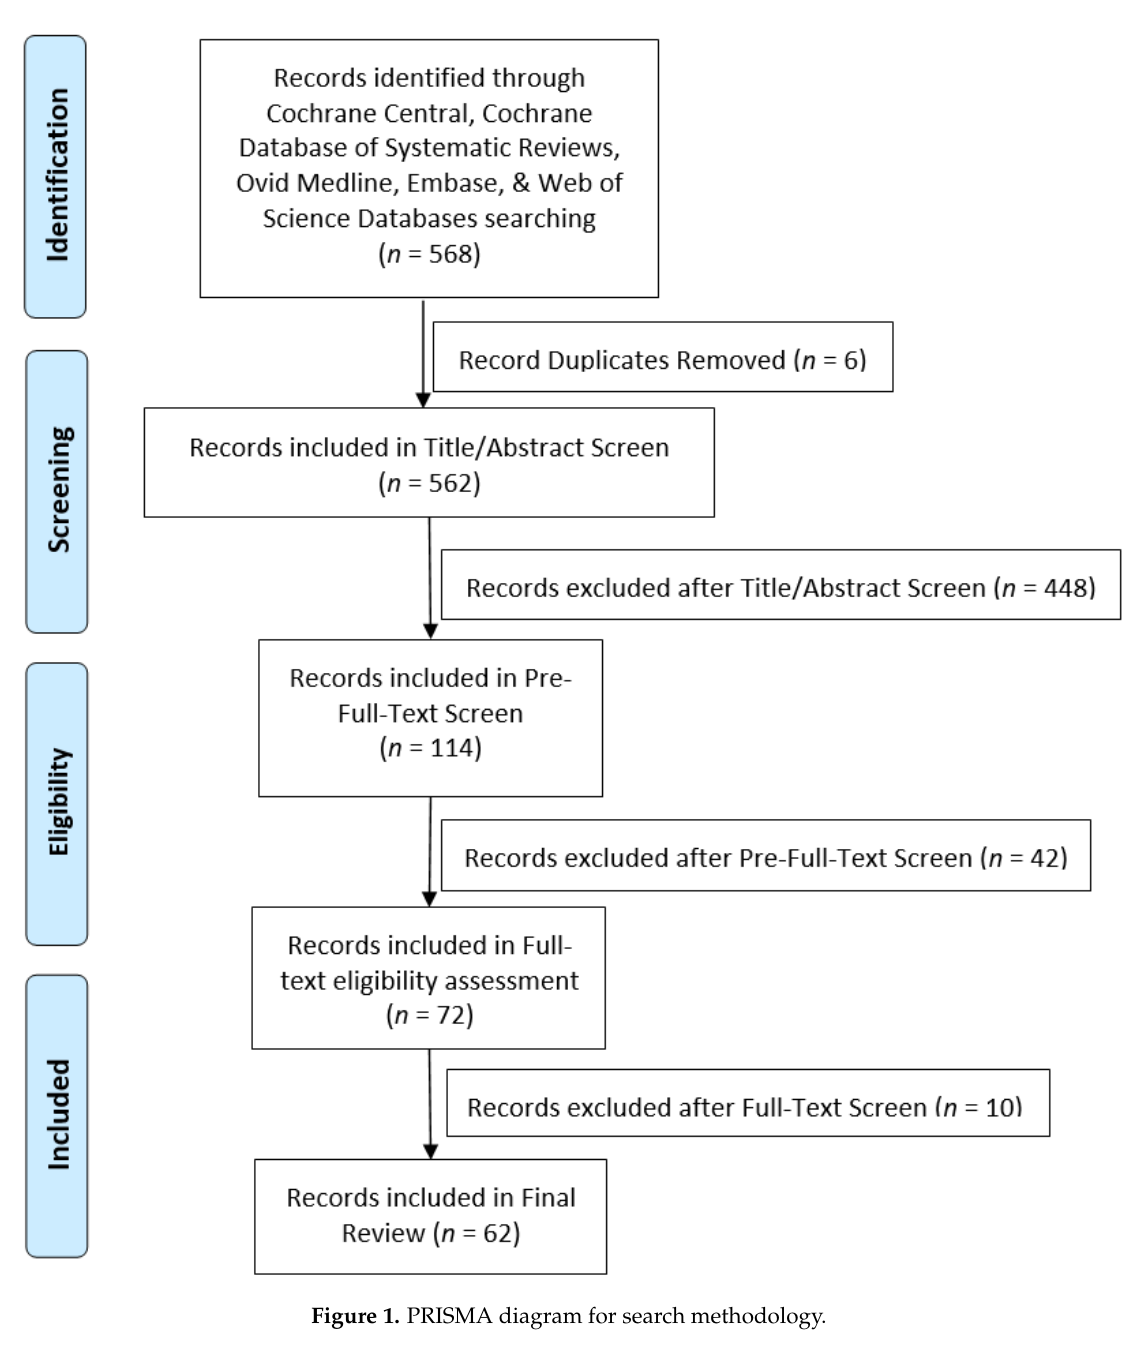
Figure 1. PRISMA diagram for search methodology.